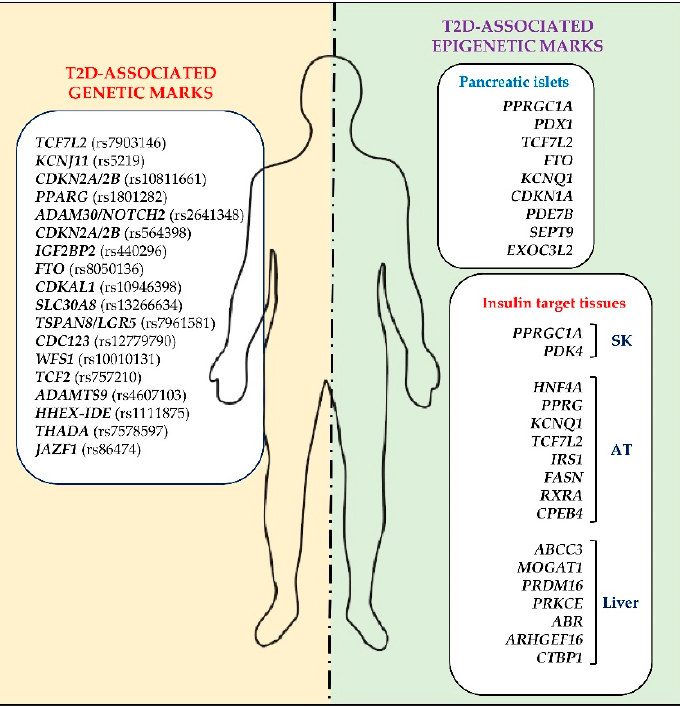
Figure 1. Genetic and epigenetic marks associated with type 2 diabetes. Showing some of the genetic variants (rs or RefSNP) and differentially DNA-methylated genes identified as associated with type 2 diabetes in humans. rs, reference single nucleotide polymorphisms; SK, skeletal muscle; AT, adipose tissue; T2D, type 2 diabetes.